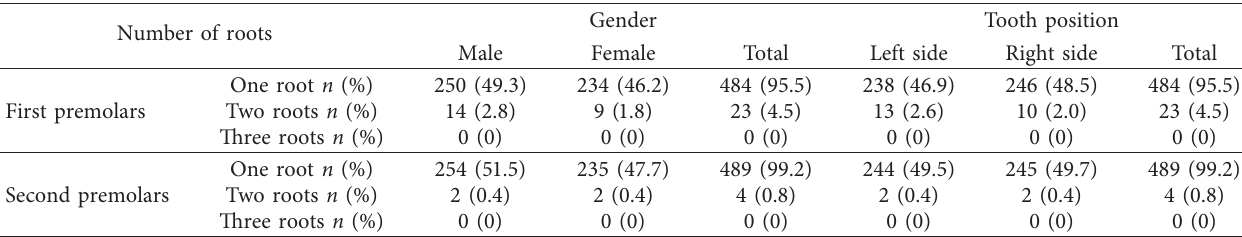
Table 2: Number of roots for gender and tooth position in mandibular first and second premolars.